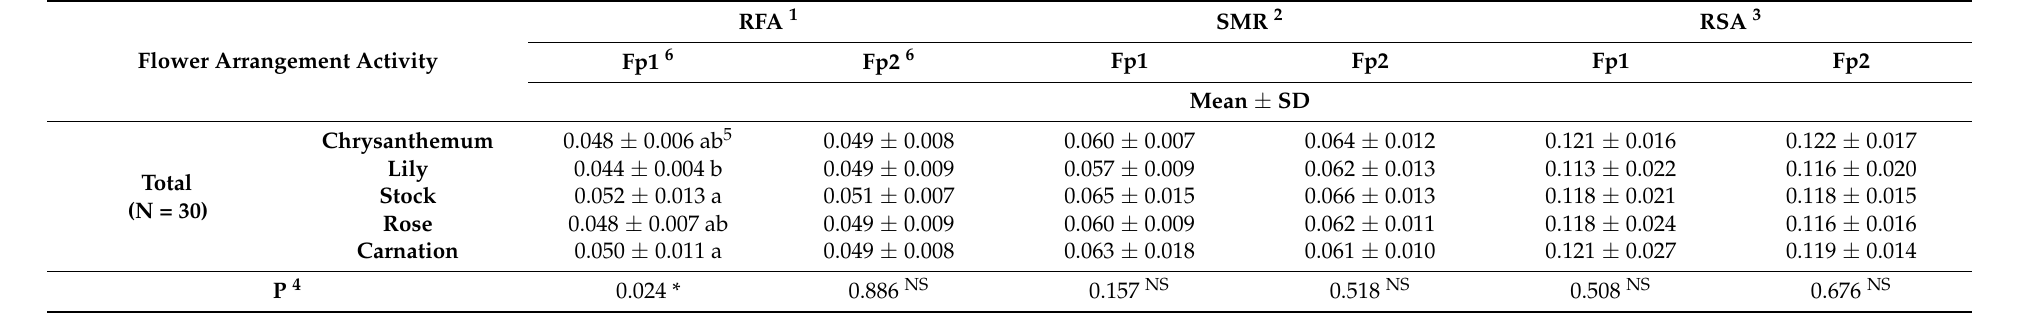
Table 3. Results of EEG values of RFA (Relative Fast Alpha), SMR (Sensorimotor Rhythm), and RSA (Relative Slow Alpha) indicators according to the activity using each plant (N =